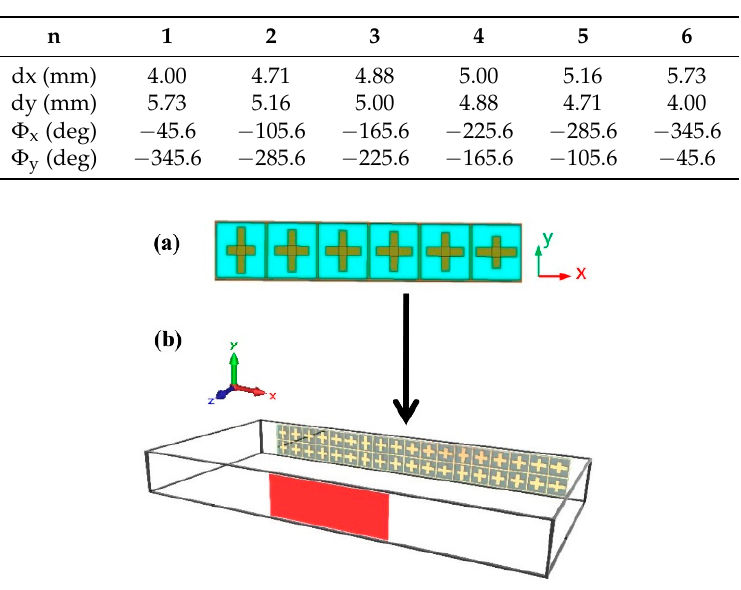
Figure 4. The schematic of the designed metasurface. ( a ) A supercell consists of six cells, ( b ) the designed metasurface constituted of 3 × 2 supercells.